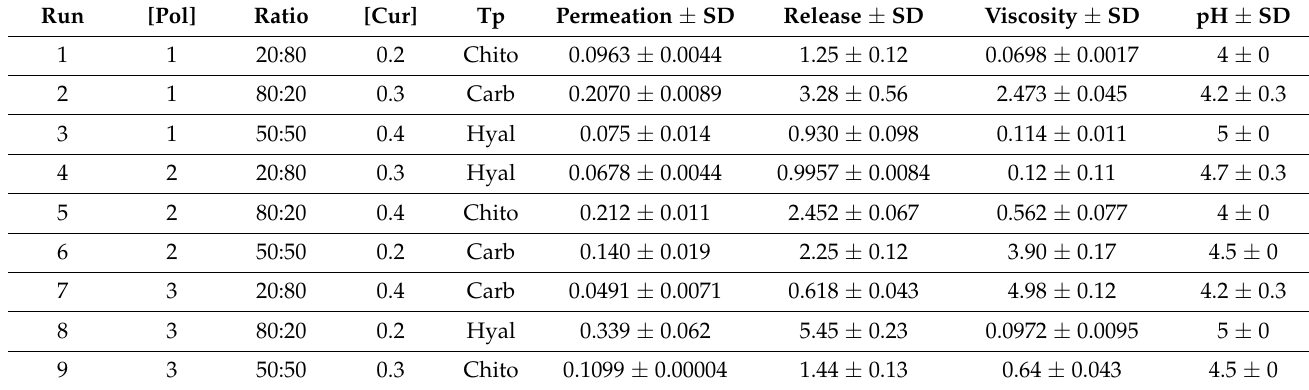
Table 1. Experimental matrix for the Taguchi L9 array and results obtained. Results show the amount of Curcumin permeated (Permeation, %) and released (Release, %), gel apparent viscosity (Viscosity, Pa · s) and pH. [Pol] represents the concentration of different polymers expressed in % w / v ; Ratio represents the proportion in weight between Pluronic ® and the other polymer; [Cur] represents the Curcumin concentration expressed in mM; Tp represents the type of polymer as a non-numerical factor, choosing between chitosan (Chito), Carbopol ® (Carb) or sodium hyaluronate (Hyal).